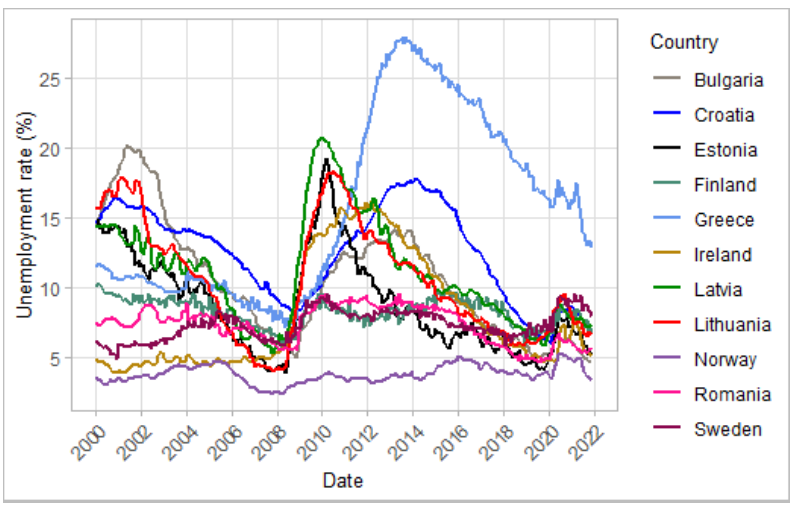
Figure 4. Comparison of the trends of the unemployment rate (seasonally adjusted